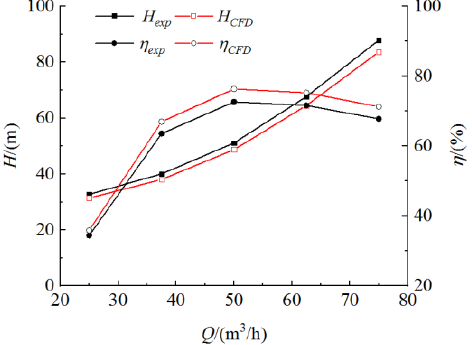
Figure 5. Comparison of performance between simulated and experimental results at α g = 0.15.